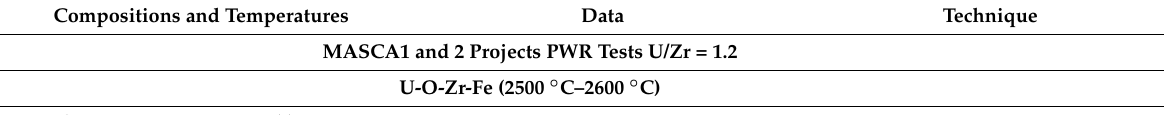
Figure 6. ( a ) O-U-Zr isothermal section modelled in NUCLEA [14] at 2873 K. ( b ) O-Fe-U isothermal section modelled in NUCLEA [14] at 2873 K. ( c ) O-Fe-Zr isothermal section modelled in NUCLEA [14] at 2873 K, NUCLEA Database 2014. Table 3. More recent experimental data related to the O-U-Zr-Fe(steel) system at high temperature in the metal-oxide composition range. (*) r = mass of iron/(mass of iron + mass of U-Zr-O). Authors Compositions and Temperatures Data